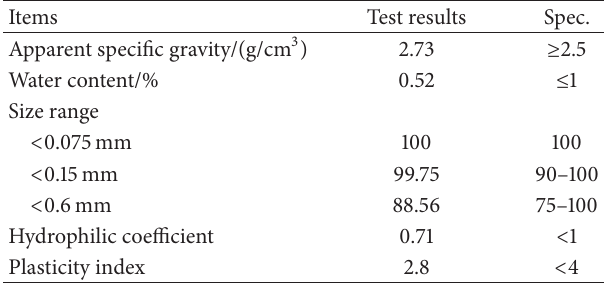
Table 5: Properties of mineral powder.